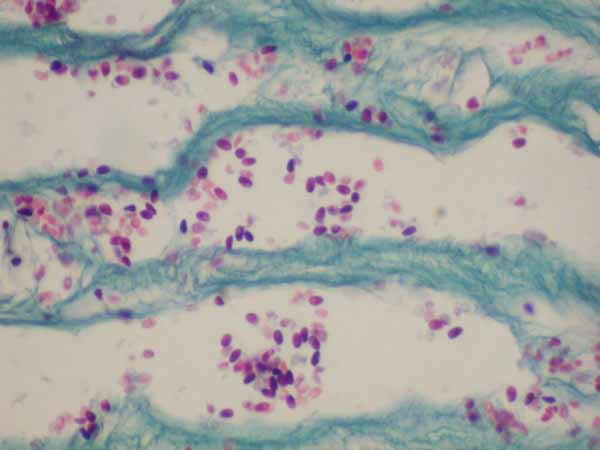
Section of corneal button which shows oval bluish purple spores of microsporidia with a dark band (modified grams chromotrope stain, ×1000).